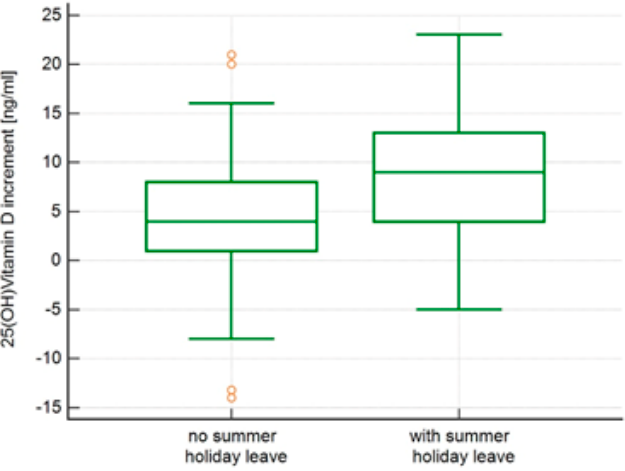
Figure 3. Comparison of vitamin D increments [ng/mL] between individuals who had at last two-week period of summer holiday leave (Mann-Whitney U-test, p = 0.005). The above-mentioned holiday-related increases in vitamin D concentrations were sig- nificant for both sexes ( p = 0.0086 and p = 0.0089, for women, and men, respectively), with no significant difference in the degree of vitamin D increments between men and women ( p = 0.13). It should be mentioned that given the concurrent COVID-19 pandemic, in a great majority of cases, holidays were spent in Poland, with only one person traveling to Croatia and one to Norway. When two week holiday period was put into a multivariate analysis, this turned out to be the only factor associated with increasing vitamin D concentrations (Table 3), while both age and BMI were no longer statistically significant. Table 3. Increments in vitamin D concentrations stratified according to having at least two-week holiday leave. The difference is statistically significant ( p = 0.005). Vitamin D Increment (ng/mL)